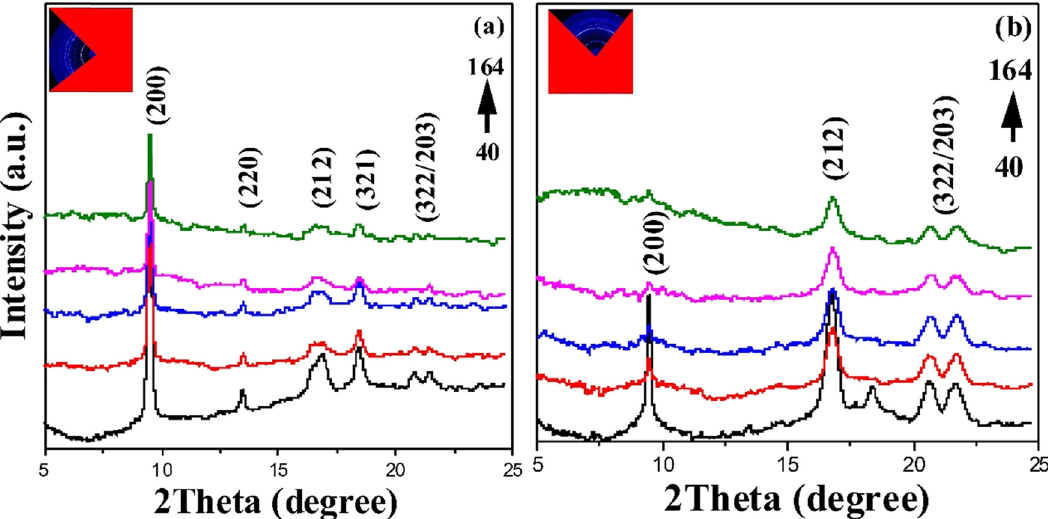
Figure A1: The integral curves of WAXS patterns along meridional ( a ) and equatorial ( b ) direction of PMP cast fi lms prepared at di ff erent MDRs; the insert picture means the integral area.